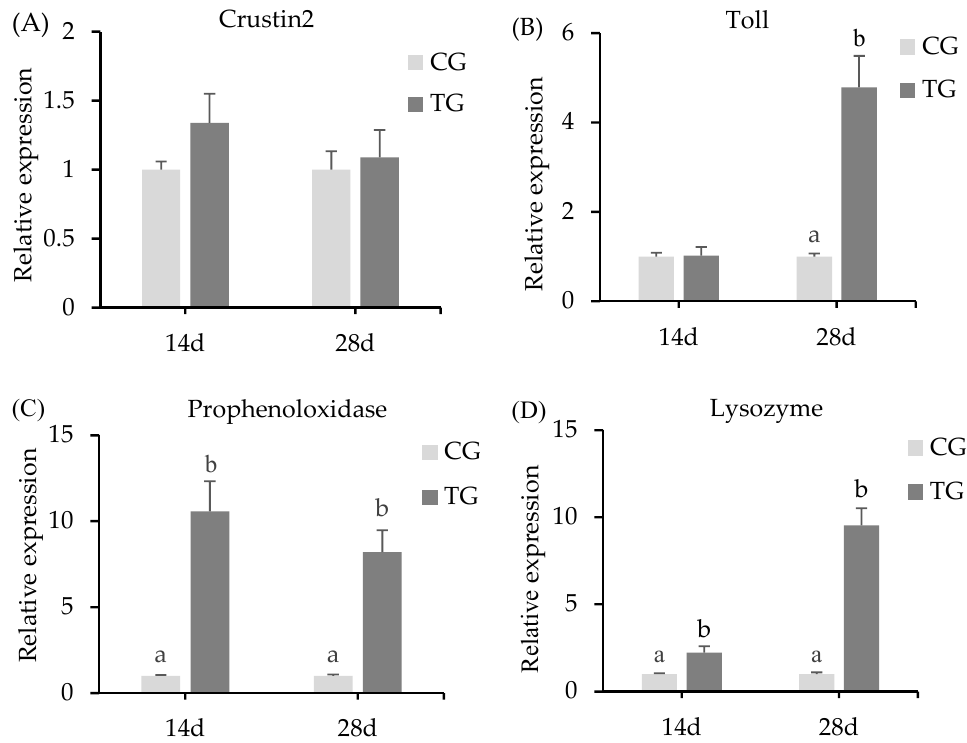
Figure 2. Relative mRNA expression of immunity-related genes in crayfish hepatopancreas tissue after the feeding trial. ( A ): Crustin2 gene expression; ( B ): toll gene expression; ( C ): prophenoloxidase gene expression; ( D ): lysozyme gene expression. Each value represents mean ± SD ( n = 3), and bars with different letters indicate significant differences by the LSD test for each time point ( p < 0.05). CG, control group; TG, treatment group ( S. cerevisiae at 10 7 CFU/g